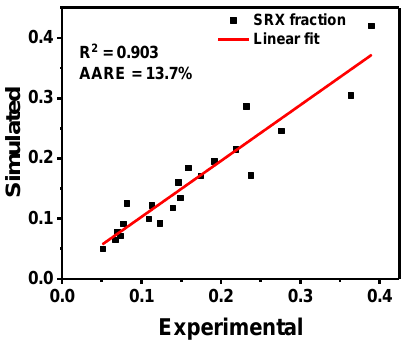
. ε , ( b ) lnε, and ( c ) 1000/T. , ( b ) ln ε , and ( c ) 1000 / T. ln ε̇